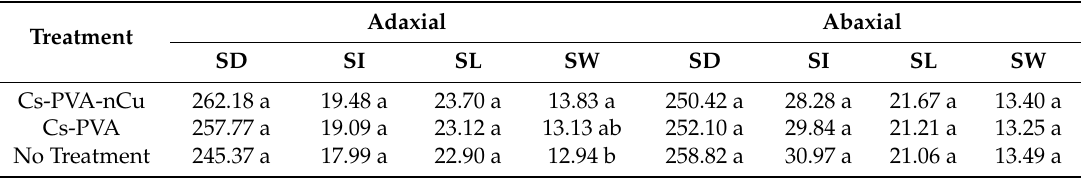
Table 7. Effect of Cs hydrogel treatments on watermelon leaf micromorphology. Adaxial Treatment